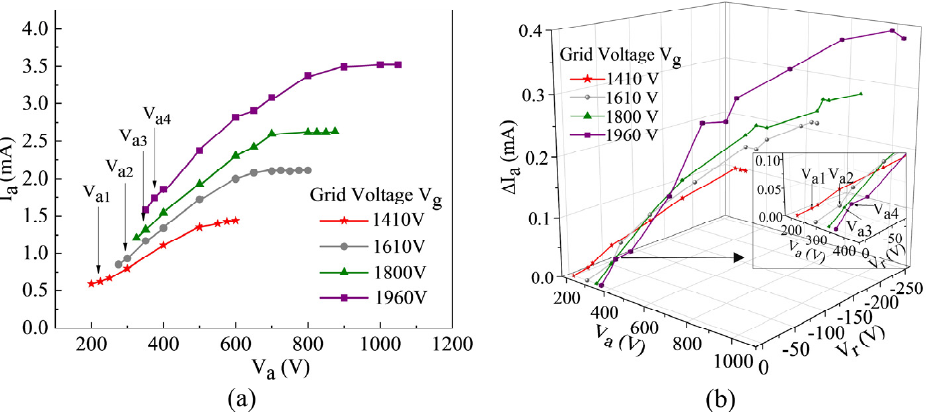
Figure 4. Corresponding to fixed V g at V r = 0 V: ( a ) I a as a function of V a , ( b ) ∆ I a as a function of V a and V r . Inset of ( b ): expanded view of the region.